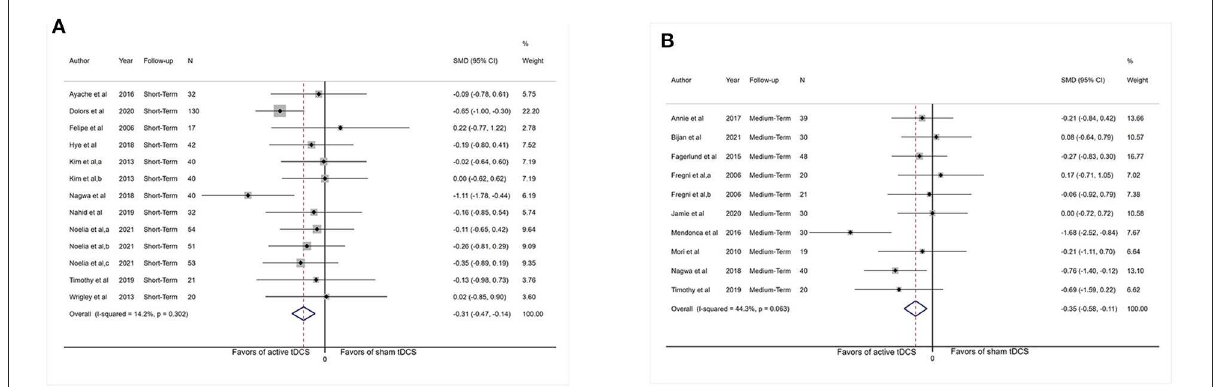
FIGURE4 Forest plot showing overall effect sizes (Hedges’ g) of real tDCS on depression within studies. These plots show the pooled SMD (large diamond shape) and I 2 resulting from the meta-analysis. (A) Depression scores from short-term data. (B) Depression scores from medium-term data. CI, confidence interval; SMD, standard mean difference; tDCS, transcranial direct current stimulation; a, motor cortex; b, dorsolateral prefrontal cortex; c, operculo-insular cortex.